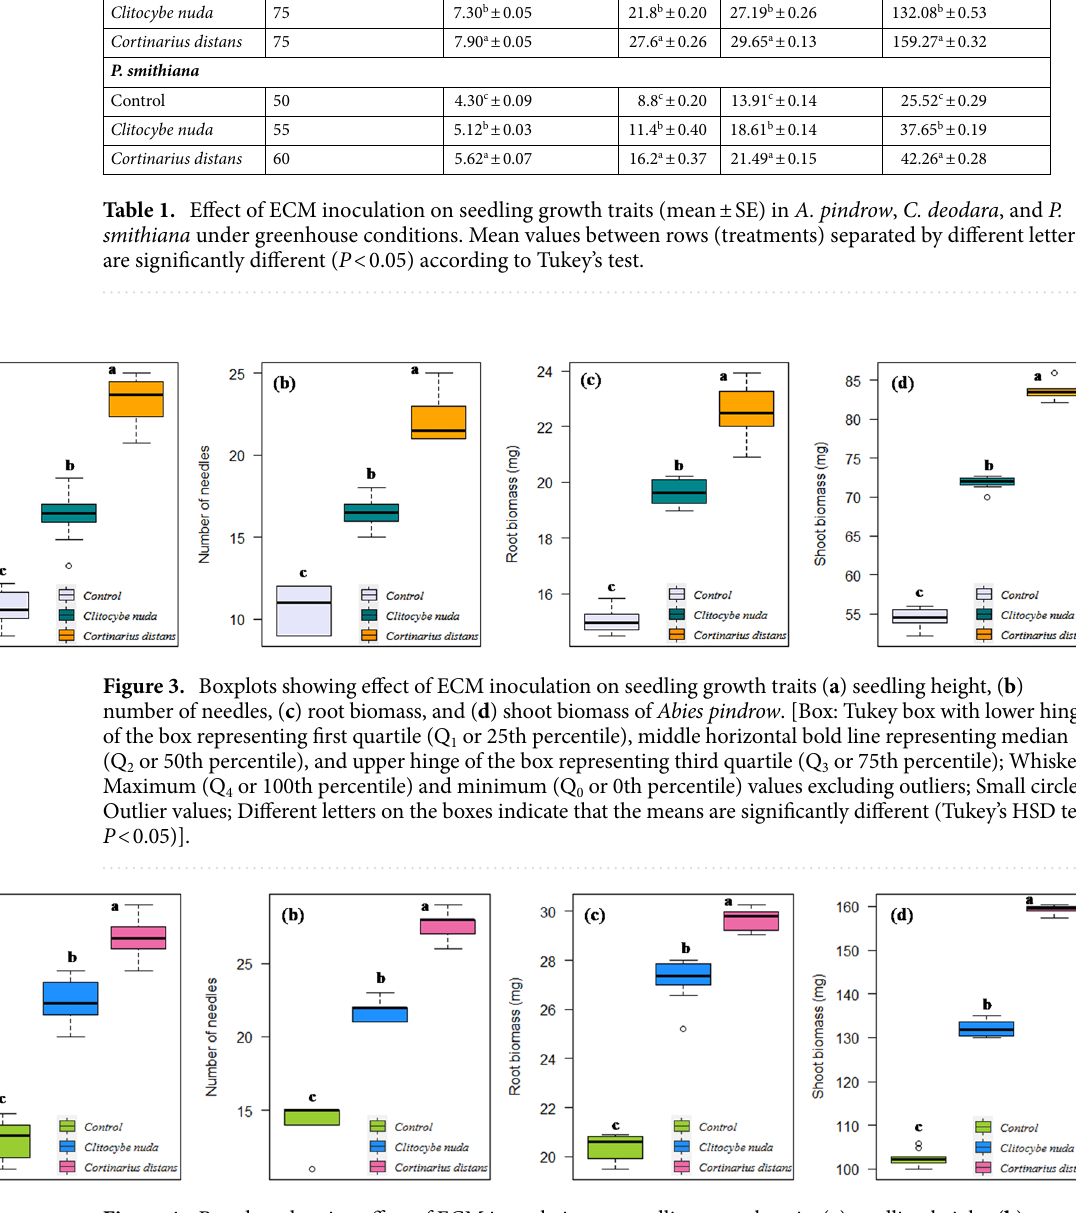
Figure 4. Boxplots showing effect of ECM inoculation on seedling growth traits ( a ) seedling height, ( b ) number of needles, ( c ) root biomass, and ( d ) shoot biomass of Cedrus deodara